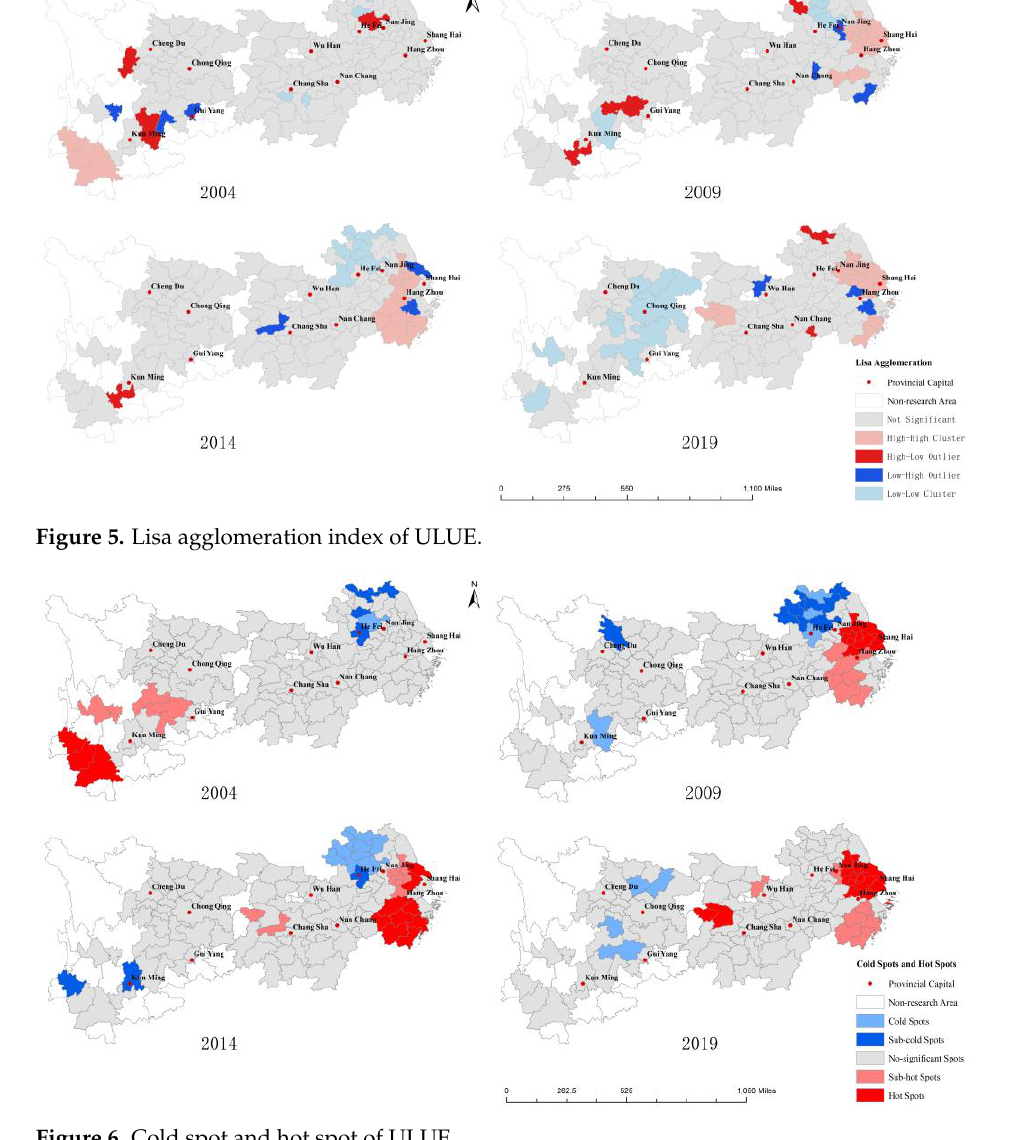
Figure 6. Cold spot and hot spot of ULUE.